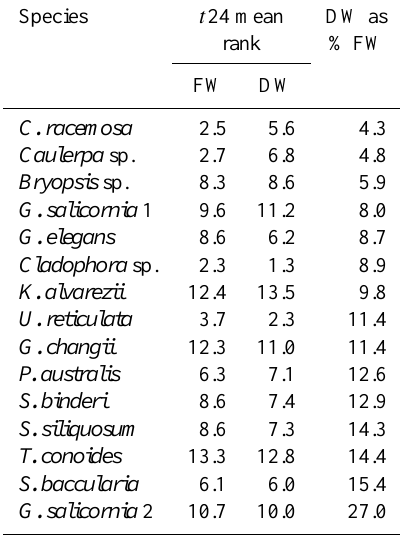
Table 3. Total mass of halogens emitted as halocarbons during in- cubation and percentage contribution to this total from bromine, chorine and iodine. Species arranged in order of decreasing total mass of halogen emitted.